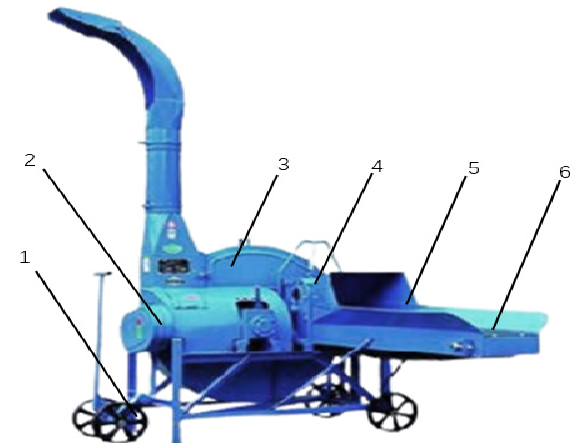
Figure 6. Corn straw shredder. Note: 1. walking device, 2. transmission device, 3. throwing chamber, 4. cutting device, 5. conveying device, and 6. conveying chain plate.